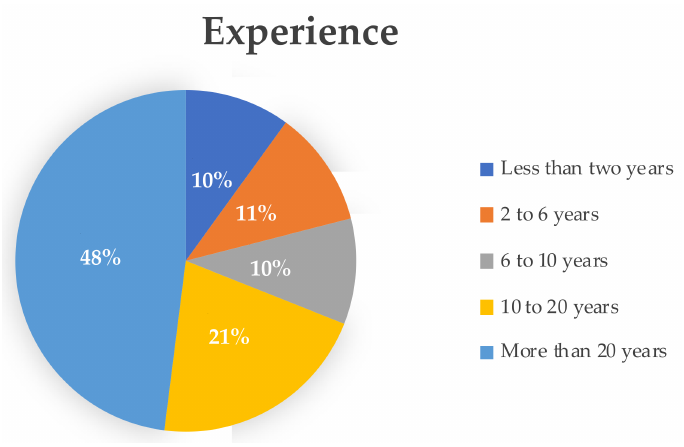
Figure 1. Level of experience of